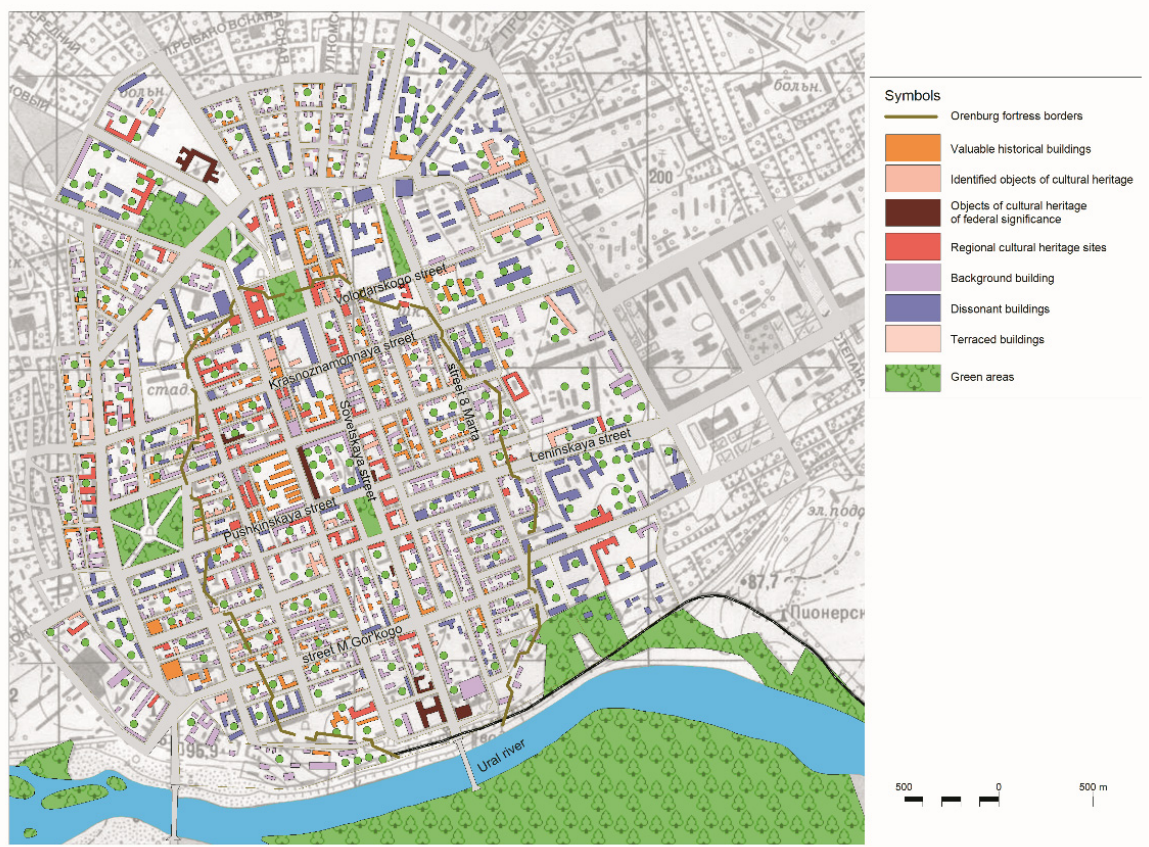
Figure 4. Development plan of the historical center of Orenburg is the territory of the former Orenburg fortress.